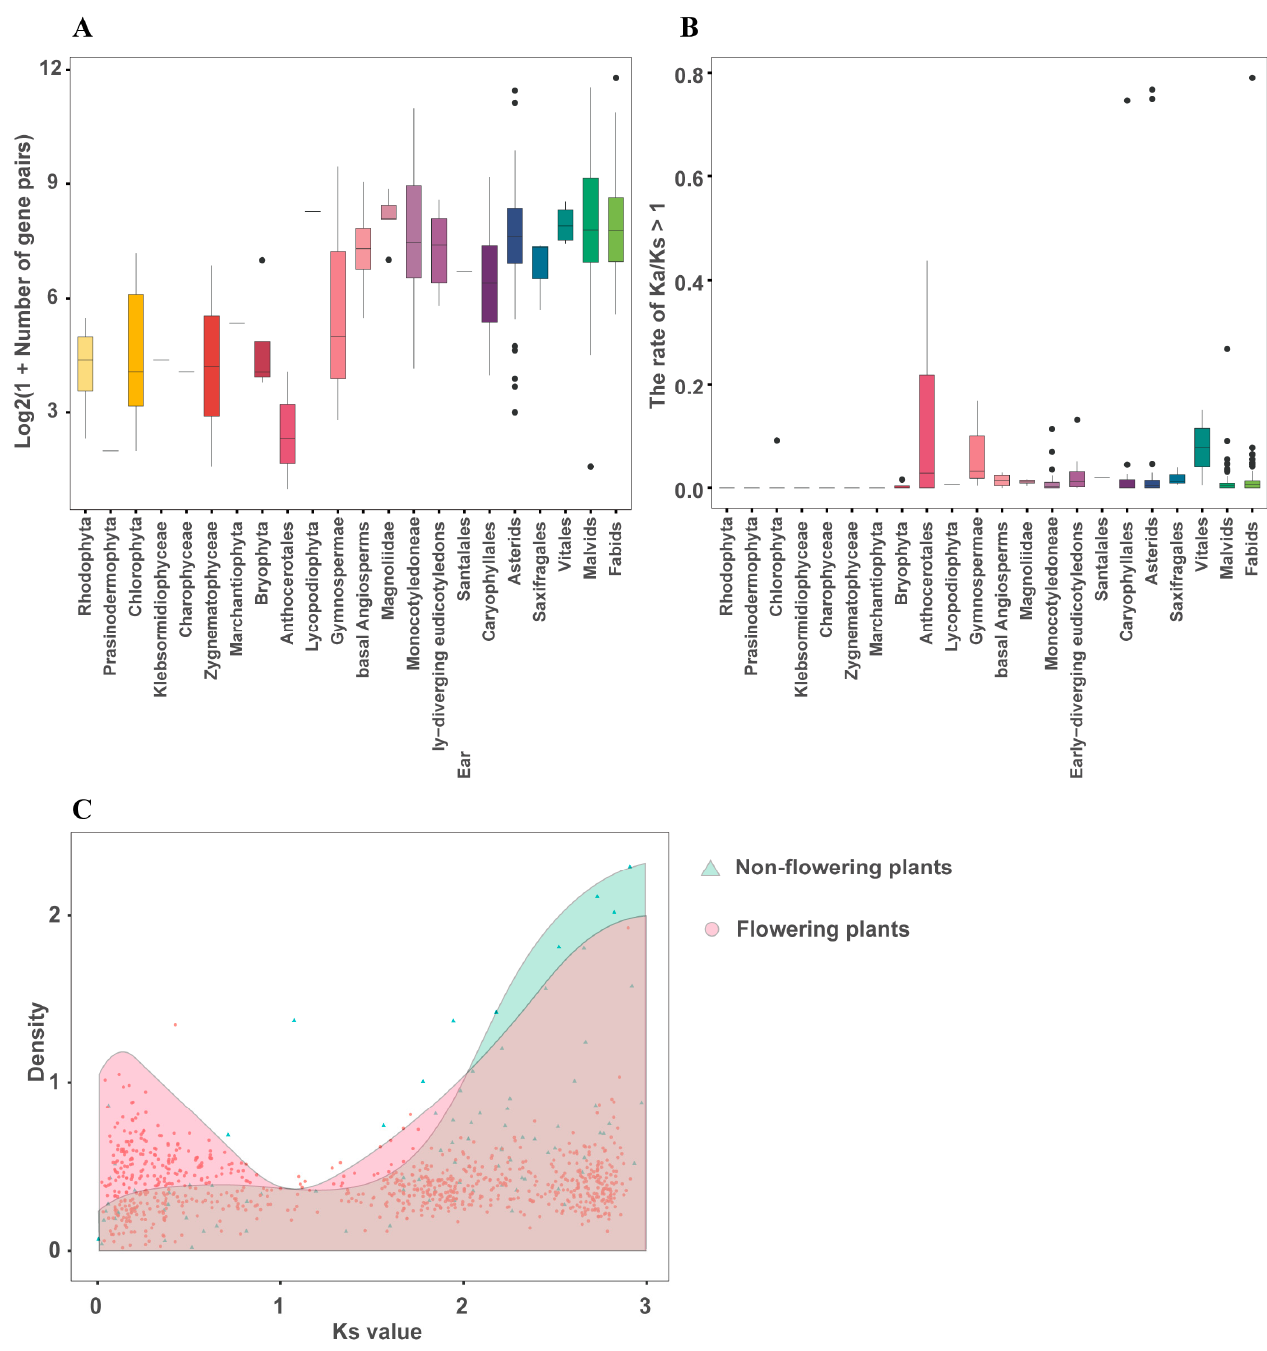
Figure 3. The number and selection landscape of MYB gene pairs in each of 22 defined categories. ( A ) Boxplot of the number of MYB gene pairs in the 22 defined categories. MYB gene pairs of each species were identified by orthofinder. The total number of MYB gene pairs for each plant species was used for plotting. Dark dots indicate species outliers, and the horizontal lines represent the medium of the values. ( B ) Boxplot of the proportion of MYB gene pairs in each species with nonsynonymous to synonymous substitution (Ka/Ks) value > 1. The proportion was calculated for each species and used for plotting. Dark dots indicate species outliers, and the horizontal lines represent the medium of the values. ( C ) The distribution of the mean Ks values for MYB gene pairs in flowering and non-flowering plants. The points represent the mean Ks values for MYB gene pairs of each of 437 species. The green background shows non-flowering plants, and the red background shows flowering plants. Only gene pairs with Ks value < 3 were included in these